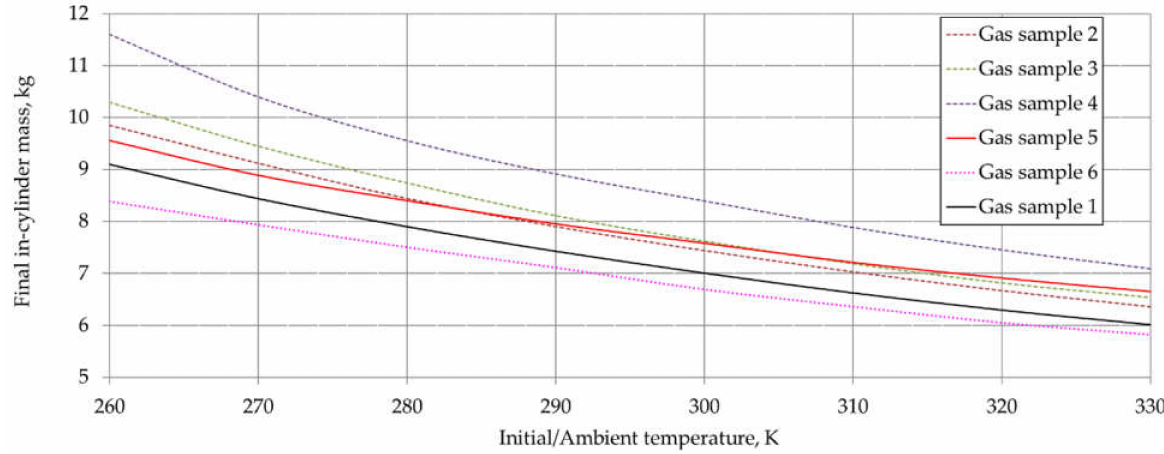
Figure 10. Influence of the initial (ambient) temperature on the mass of fueled natural gas mixtures and